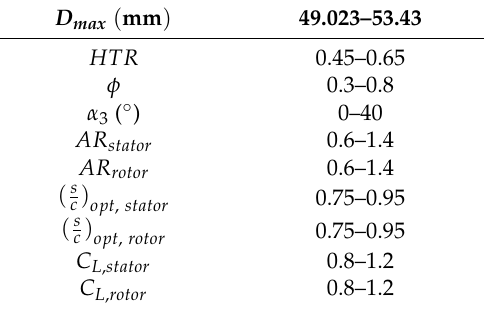
Table 4. Design parameter